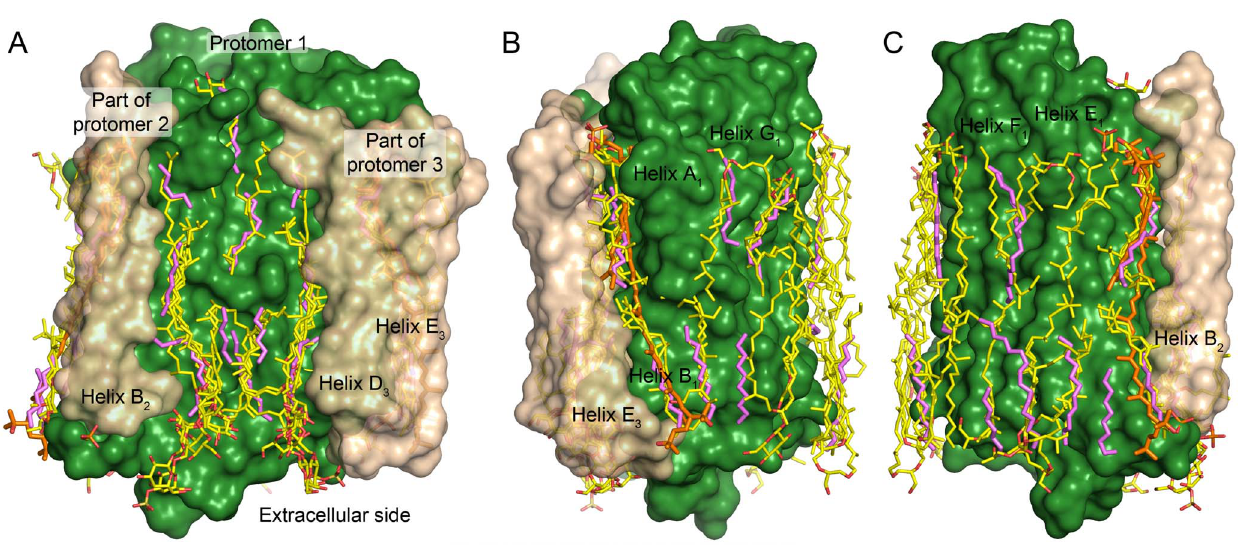
Figure 8. Comparison of the ordered lipidic tails observed in Hm BRI structure with those observed in the structures of trimeric Hs BR [23,34–36] , ar-2 [29] and dr-3 [13] . The Hm BRI surface is shown in green, parts of the adjacent protomers are in beige, Hm BRI lipids are in magenta, the other lipids are in yellow and bacterioruberin molecules observed in aR-2 and dR-3 structures are in orange. (A) Lipids inside the trimer. (B) Lipids close to the helices A, B and G. (C) Lipids close to the helices E and F. To obtain the positions of the lipidic moieties observed in the structures of the other proteins, their trimeric assemblies were aligned first to Hm BRI